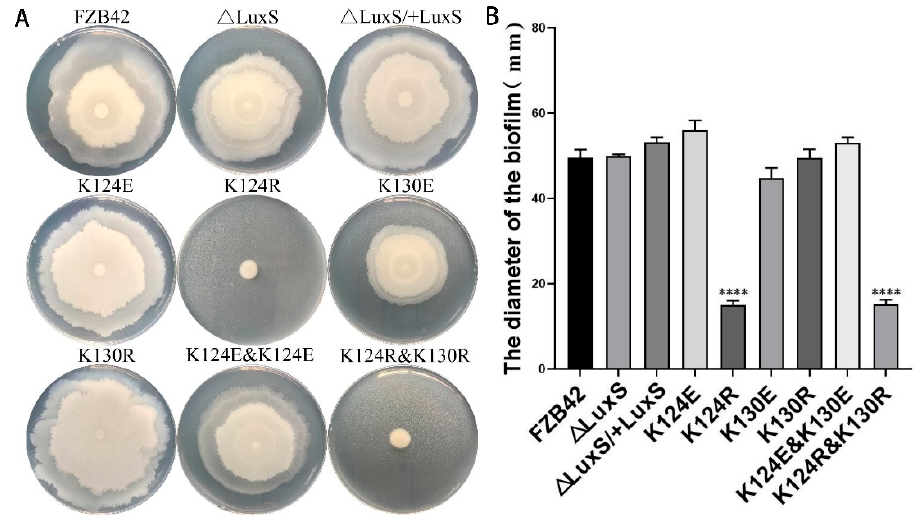
Figure 3. Swarming result of FZB42 WT and its derived mutants. The strains were grown on LB plates containing 0.5% agar at 37 °C for 10 h. ( A ) A representative set of plates showing the colonies after incubation. ( B ) Statistics of the diameters of colonies formed by the strains. ****( p < 0.0001).